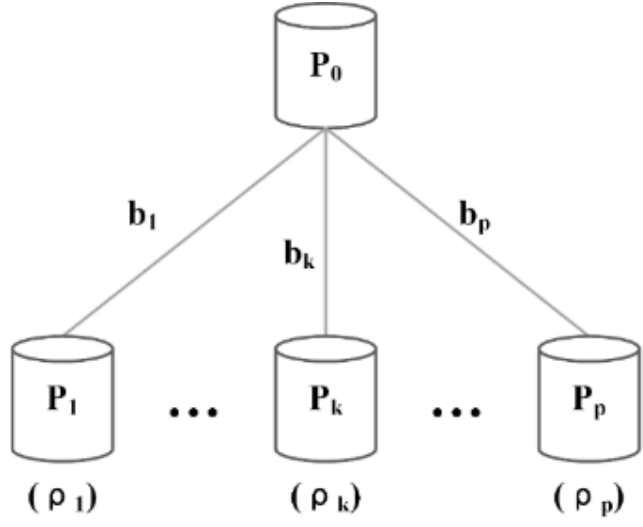
Figure 3. The target heterogeneous platform.